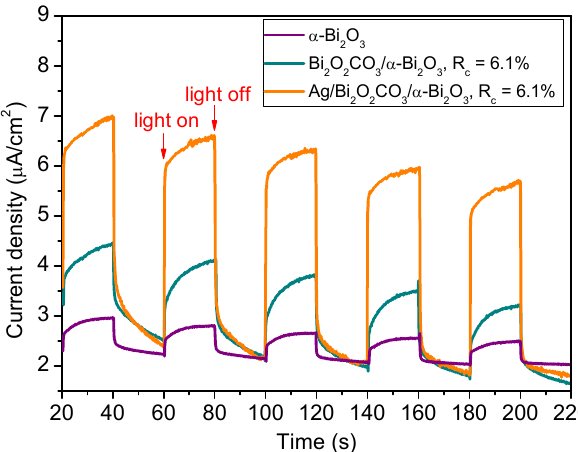
Figure 12. Photocurrent responses of different samples under visible light.